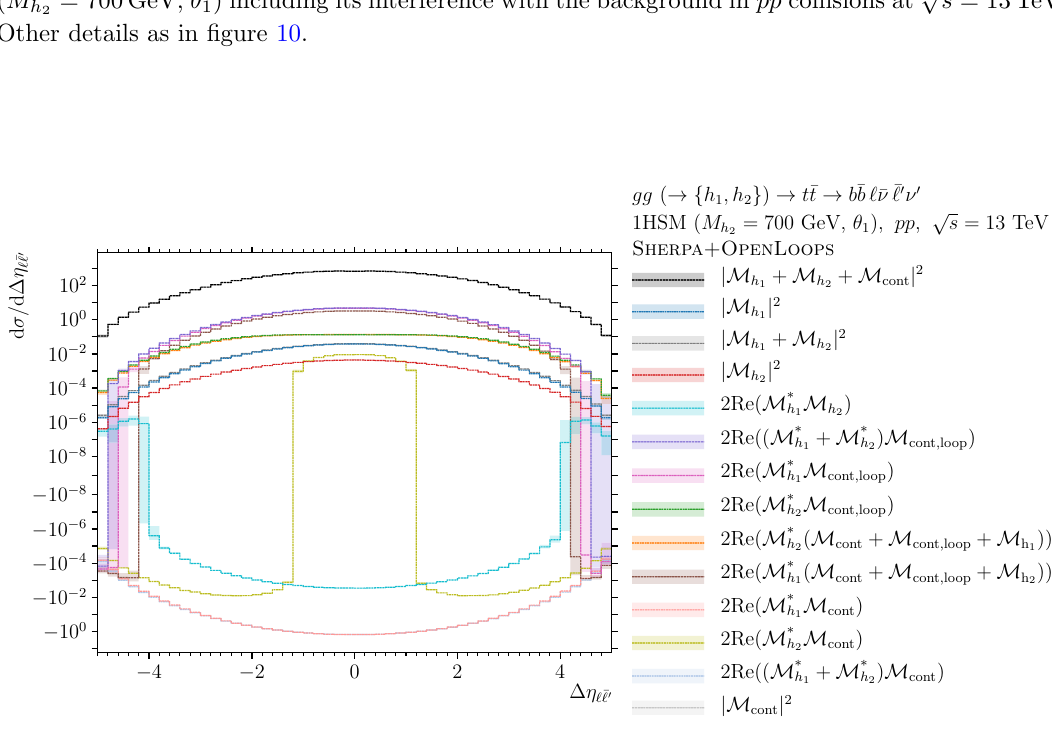
h 1 , h 2 ) t ¯ t b ¯ b (cid:25) ¯ ν ¯ (cid:25) (cid:31) ν (cid:31) in the 1HSM → { } → →